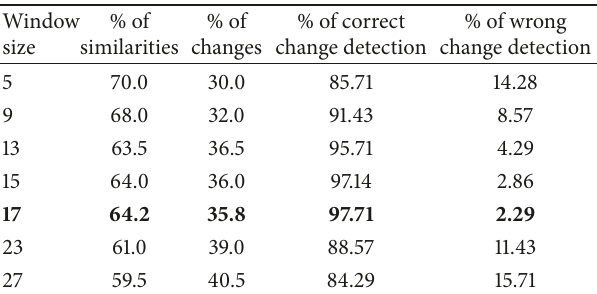
Table 2: Performance comparison in percentage between SWB- NMI and approach in [2] with different window sizes for 1st